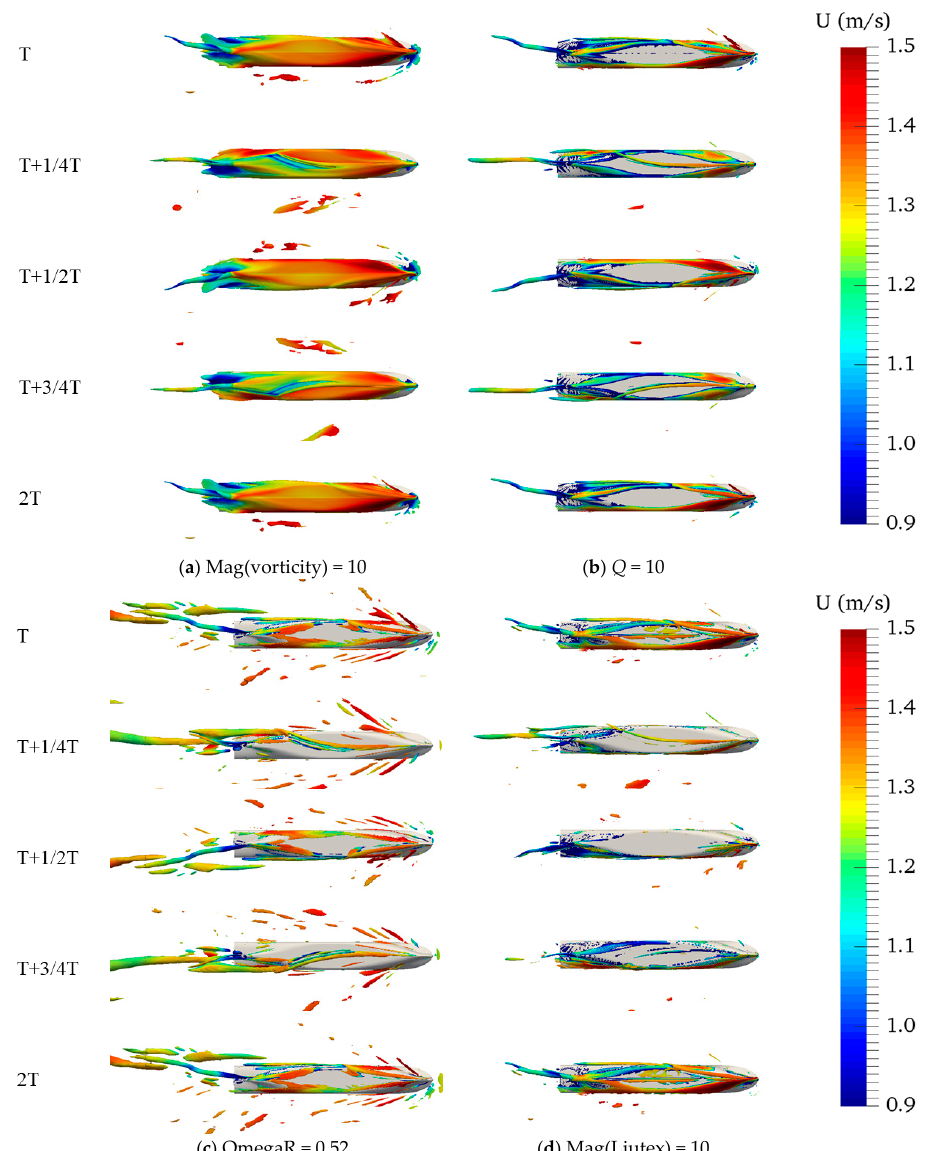
Figure 13. Vortex structure obtained by different vortex identification methods: ( a ) first generation based on vorticity; ( b ) second generation based on eigenvalues; ( c , d ) third generation in CASE PS8.